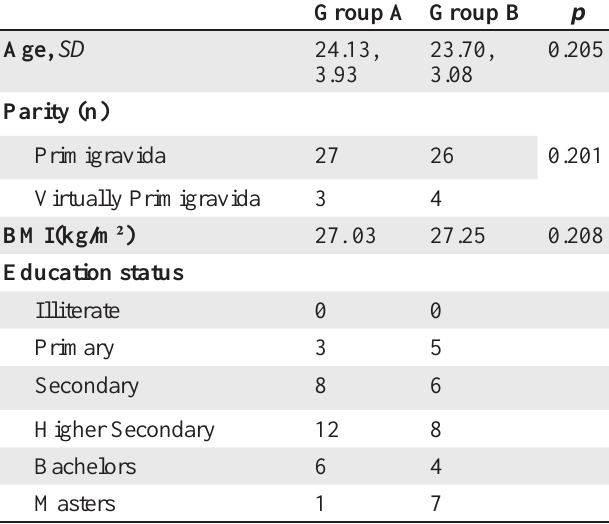
Table 1 : Demographic Distribution